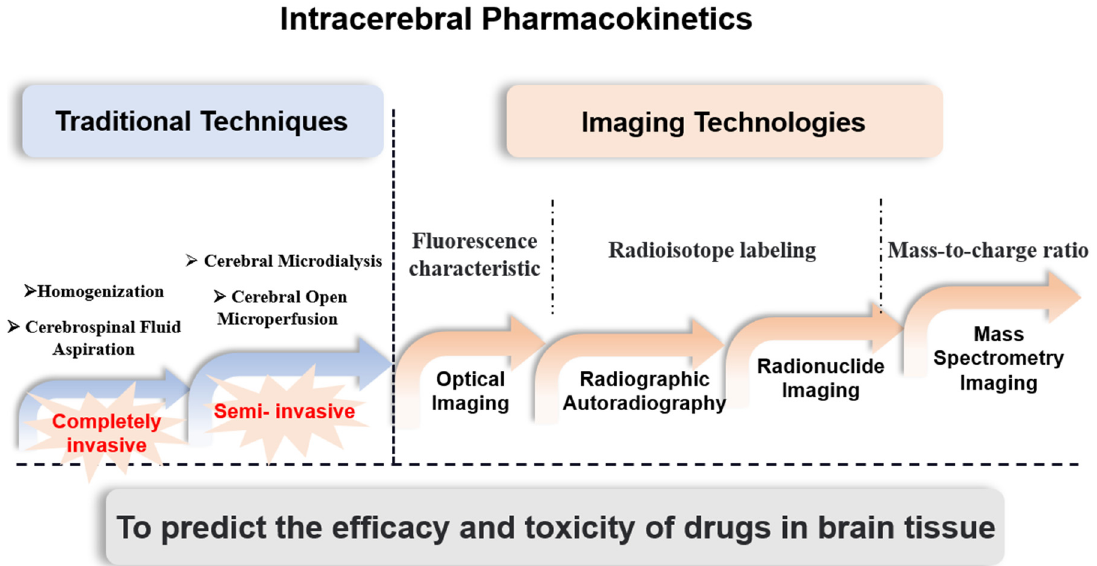
Figure 1. Development of intracerebral pharmacokinetic strategies. This review focuses on the de- velopment trends and recent advances of some imaging-based cerebral pharmacokinetic study methods, objectively assesses the advantages and limitations of various technical methodologies, and provides a reference for predicting the pharmacodynamic and toxic effects of drugs in brain